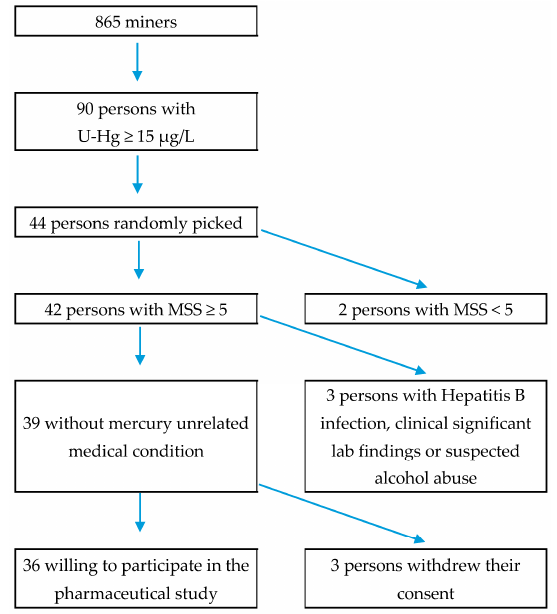
Figure 1. Flow chart of subject selection for the pharmaceutical study (MSS = chronic intoxication medical score sum).